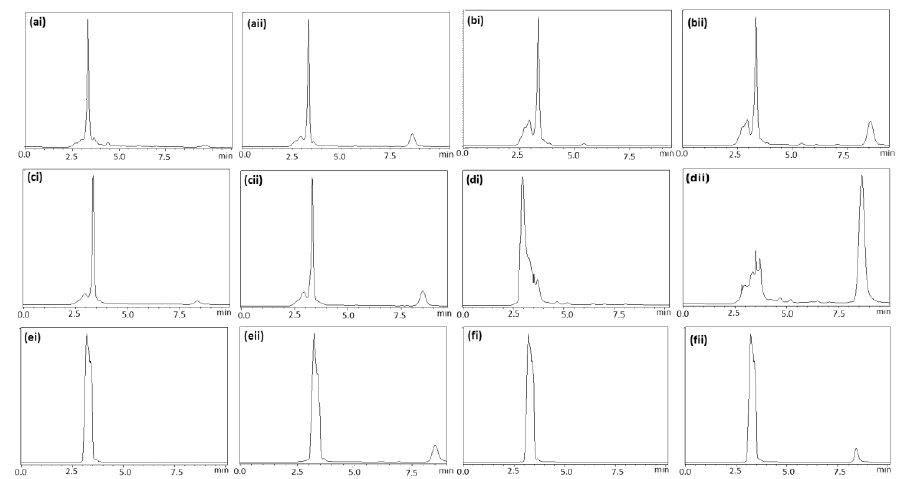
Figure 4. Chromatograms of blank samples ( i ) and their fortified parallel ( ii ): ( a ) hazelnut praline- merenda, ( b ) milk chocolate, ( c ) dark chocolate, ( d ) white chocolate, ( e ) strawberry syrup, ( f ) cherry